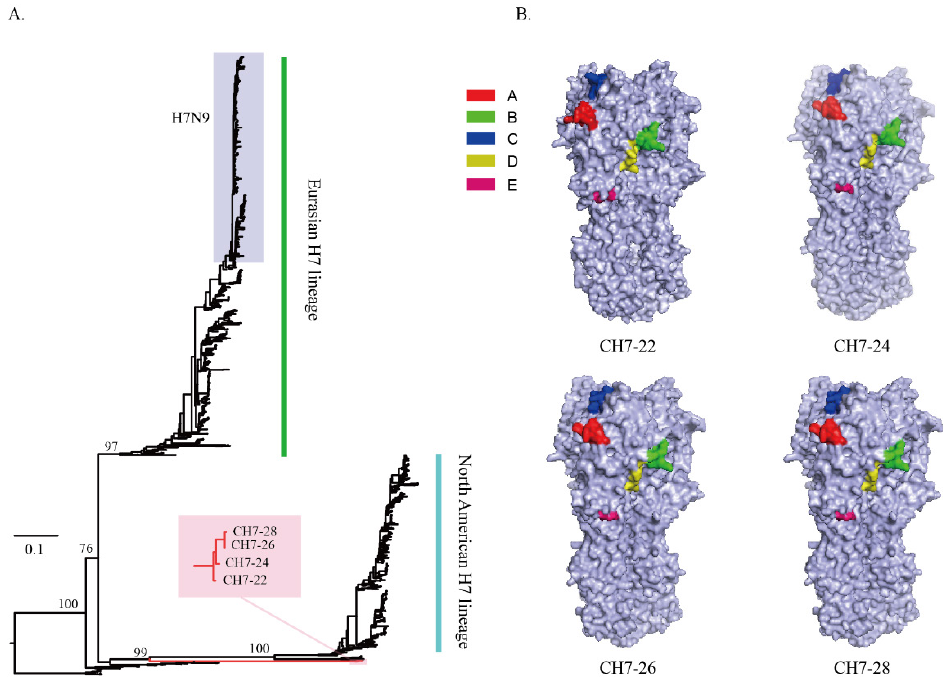
Figure 2. Phylogenetic analysis of the consensus H7 ( A ). A phylogenetic tree was inferred from the hemagglutinin amino acid sequences of H7 viruses ( n = 1502) using the maximum likelihood method, and groupings of the four consensus H7 antigens in trees were identified using Figtree software. The four consensus H7 sequences with all H7 HA proteins showed that the four consensus H7 sequences (red branch) were located on separate branches without grouping with any viruses of Eurasian and North American H7 lineages. Schematic of the three-dimensional structure of four trimerized consensus H7 proteins ( B ). After four consensus H7 sequences were constructed, homology models were created for each one using the SWISS-MODEL webserver. The antigenic sites of consensus H7 HA were identified by alignment with the A / Anhui / 1 / 2013 (H7N9) sequence. The A site is shown in red, the B site in green, the C site in blue, the D site in yellow, and the E site in medium violet-red.